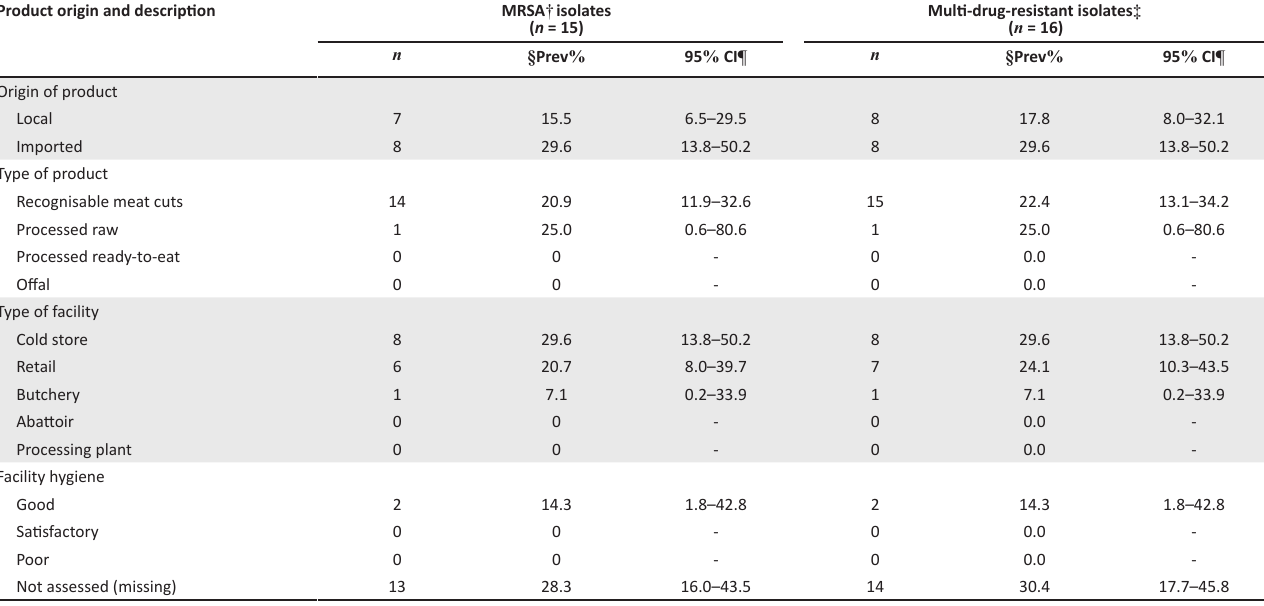
TABLE 3: Prevalence of antibiotic resistance among Staphylococcus aureus isolates ( n = 72) from poultry meat products in South Africa, 2015–2016. Product origin and description